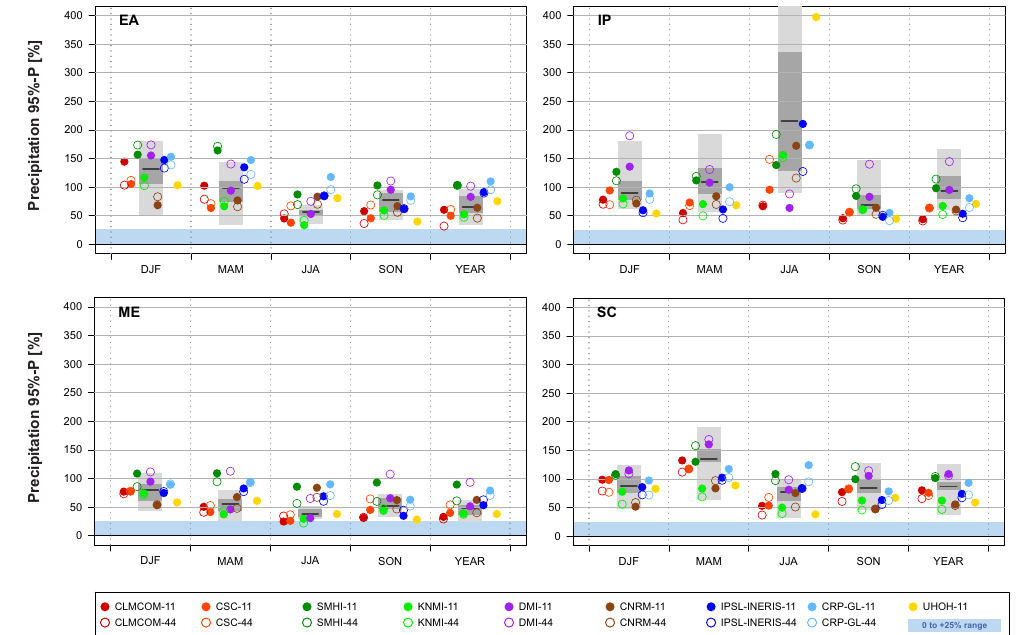
Figure 8. As Fig. 7 but for the 95th percentile of mean seasonal and annual relative precipitation biases (absolute values; 95%-P; %). The blue shading indicates a bias range between 0 and + 25%, corresponding to acceptable wet model biases in case of a systematic rain gauge undercatch of up to 20% of true precipitation. See Fig. B4 for subdomains AL, BI, FR and